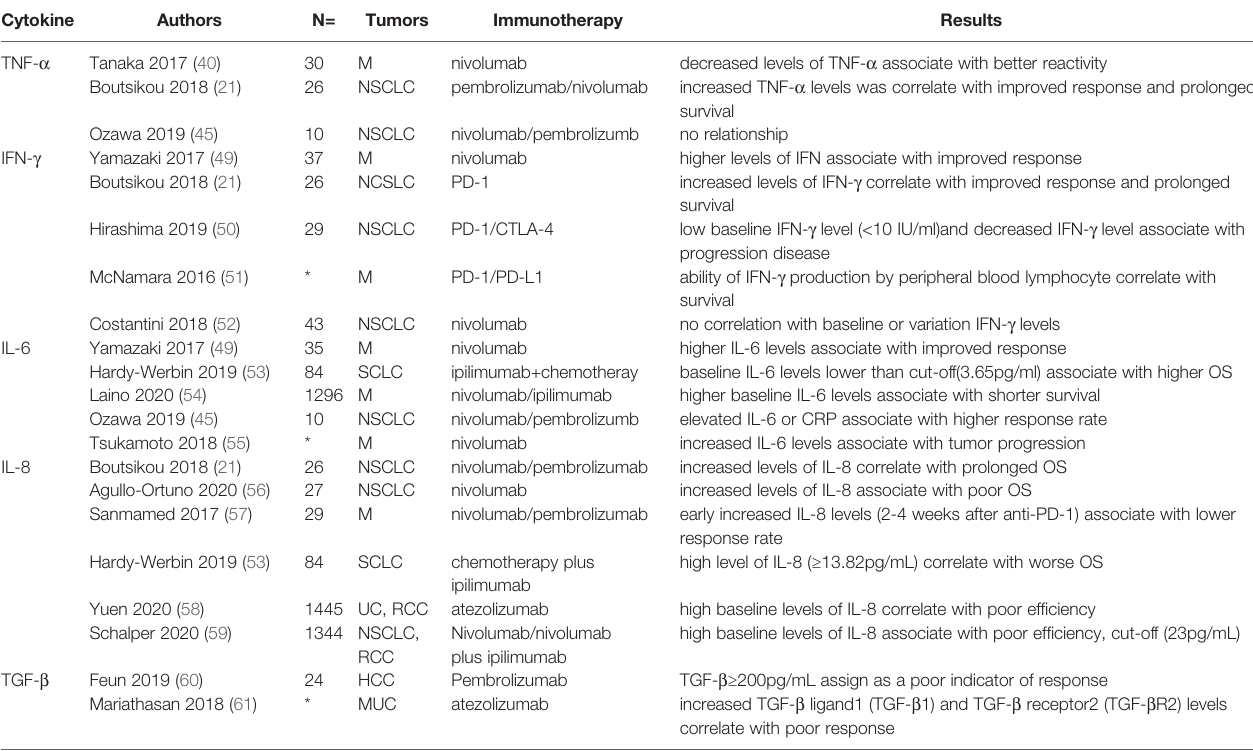
TABLE 1 | Clinical studies of the association of ICT response with cytokines. Cytokine